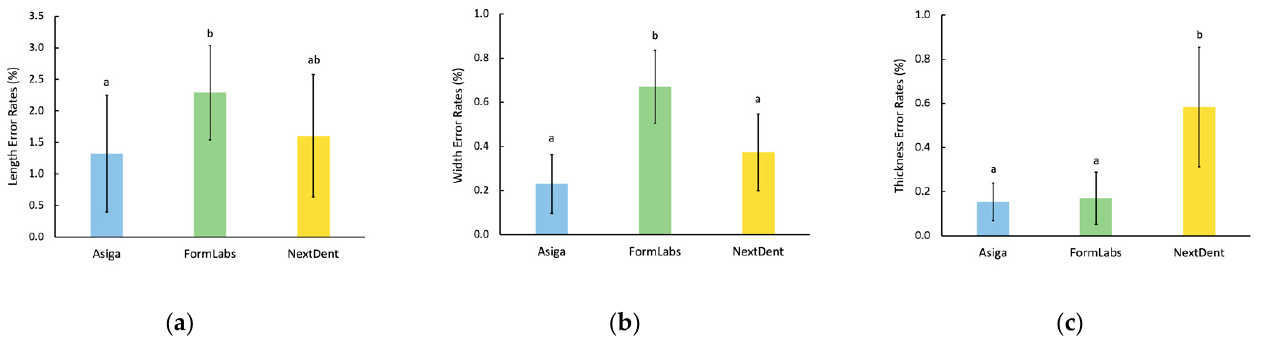
Figure 2. Printing accuracy of 3D-printed resin specimens. ( a ) Length; ( b ) Width; ( c ) Thickness. Similar letters indicate insignificant differences. Similar letters indicate insignificant